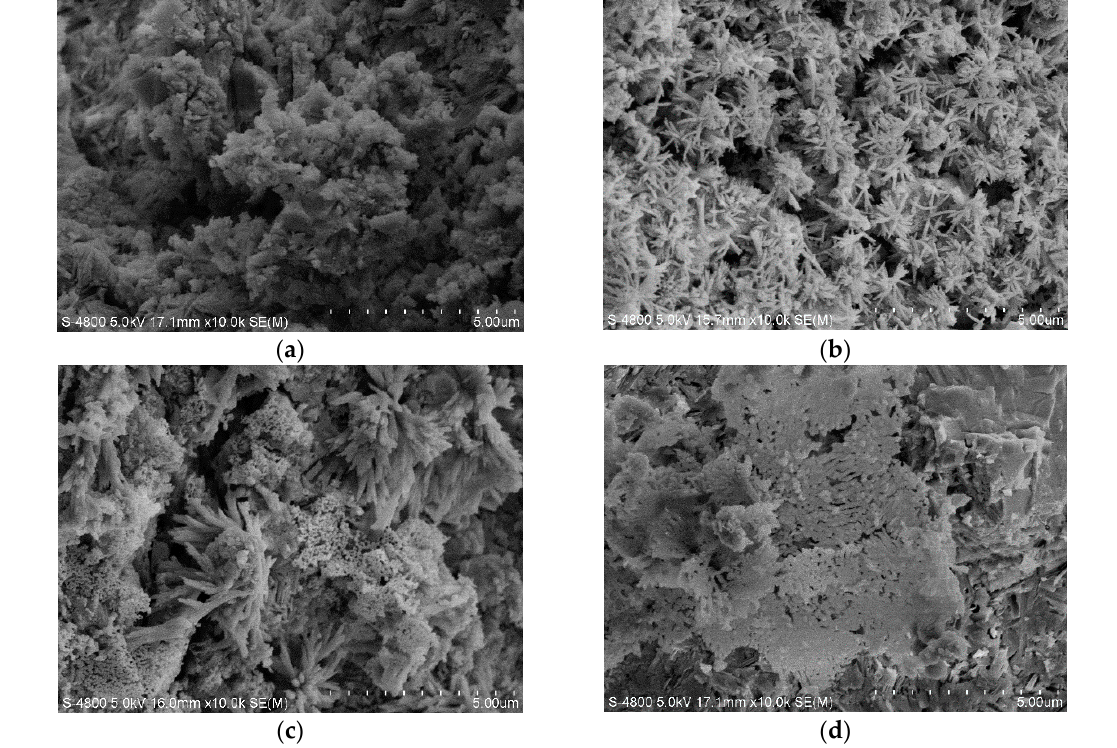
Figure 10. Morphology of cement pastes at 28 days. ( a ) 0%P 2 O 5 , ( b ) 1.5%P 2 O 5 , ( c ) 2.0%P 2 O 5 and ( d ) 2.5%P 2 O 5